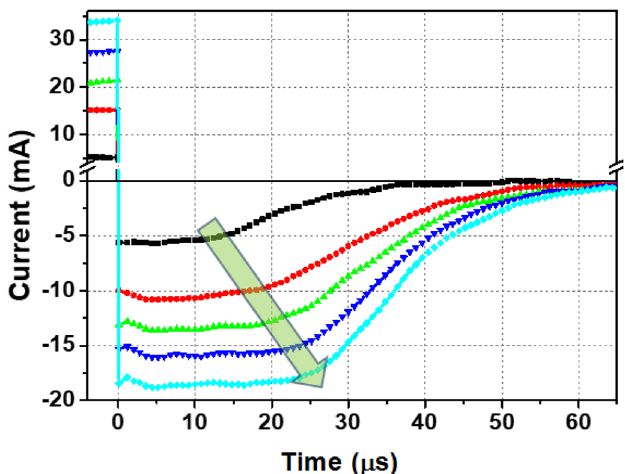
Fig. 5. T rr current for a PEDOT:PSS/n-Si heterojunction solar cell with different forward currents.